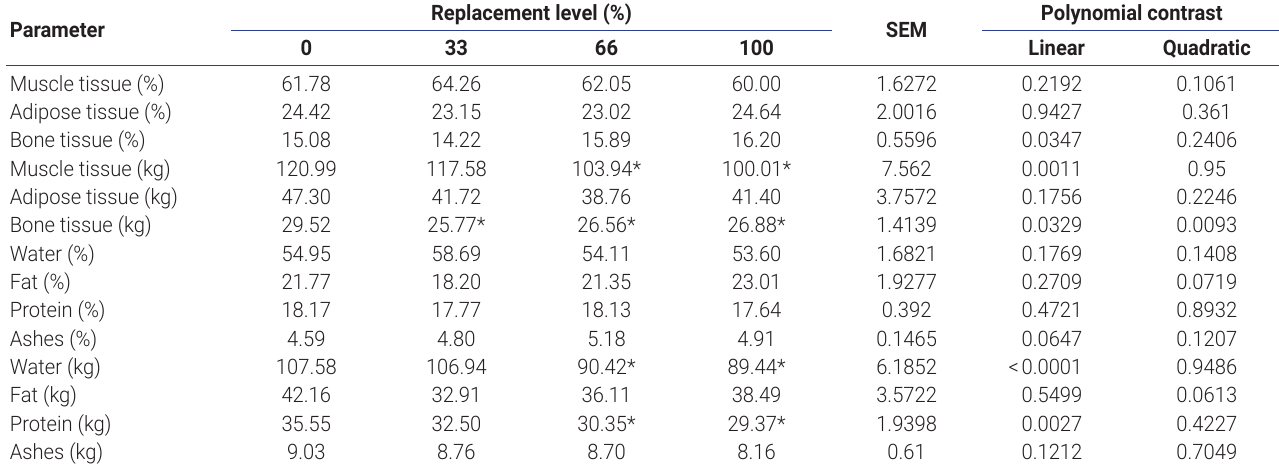
Table 3. Physical and chemical composition 1) of the carcass of buffaloes fed sugarcane-based diets supplemented with spineless cactus